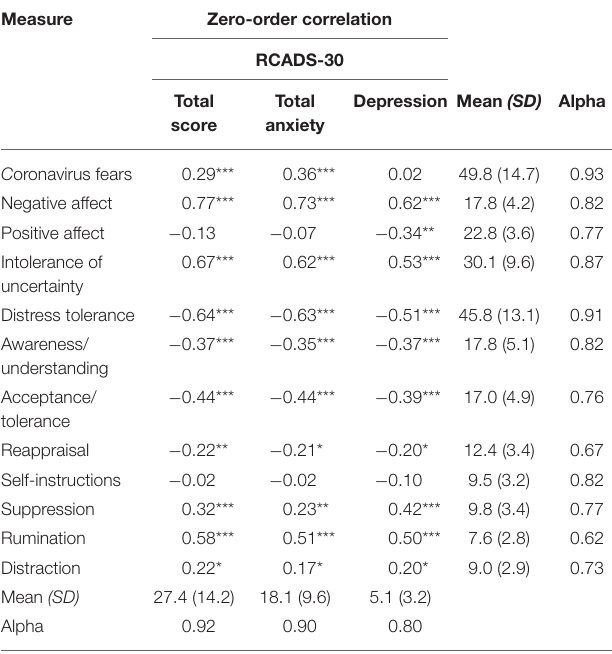
TABLE 2 | Product-moment correlations of coronavirus fears and transdiagnostic measures with symptoms of anxiety and depressive disorders.